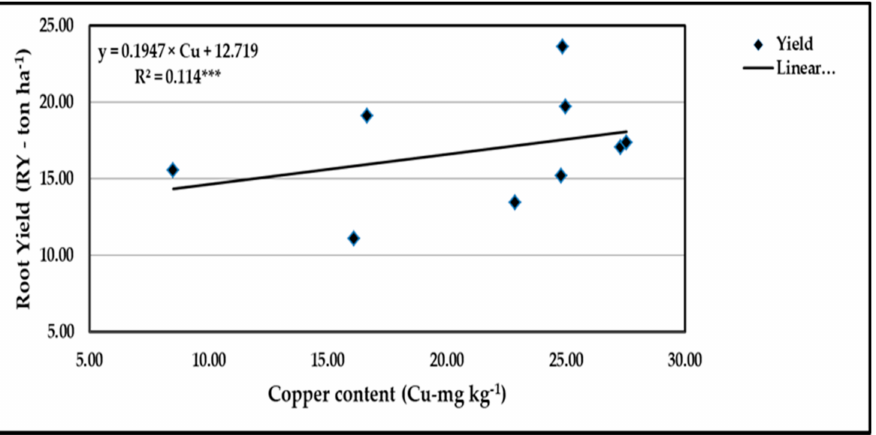
Figure 21. Contribution of Cu content to the quadratic response of stressed sweet potato to different levels of ascorbic acid and zinc oxide nanoparticles in the 2020 season. *** indicates differences at p ≤ 0.001 probability